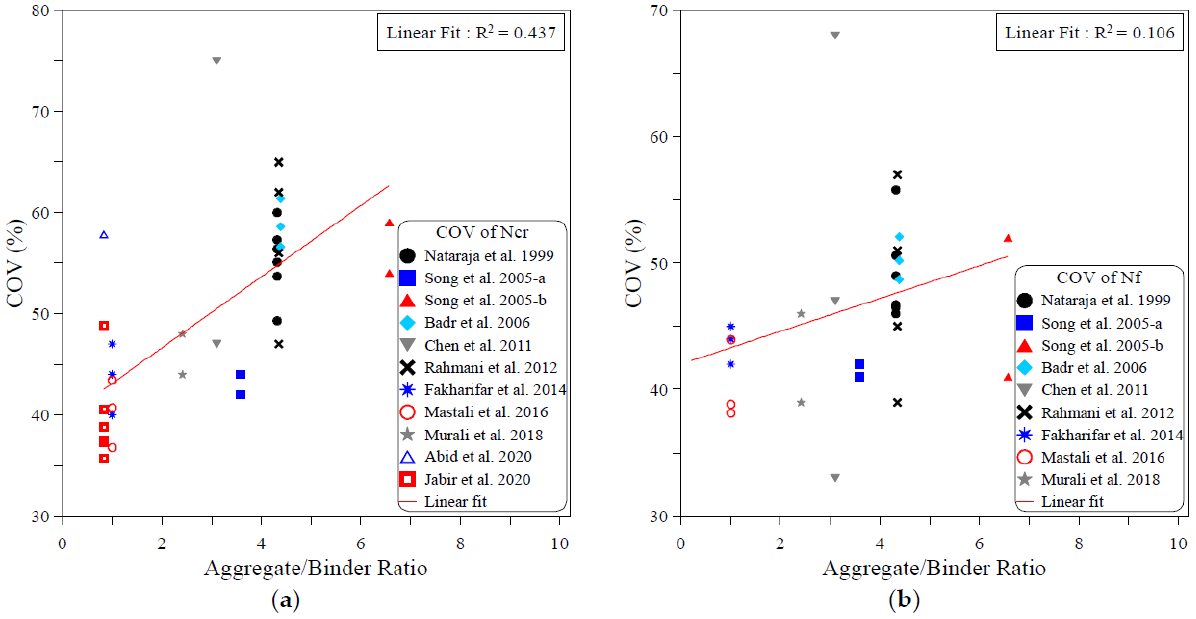
Figure 3. Effect of aggregate content on the scattering of impact results at ( a ) cracking and ( b ) failure.